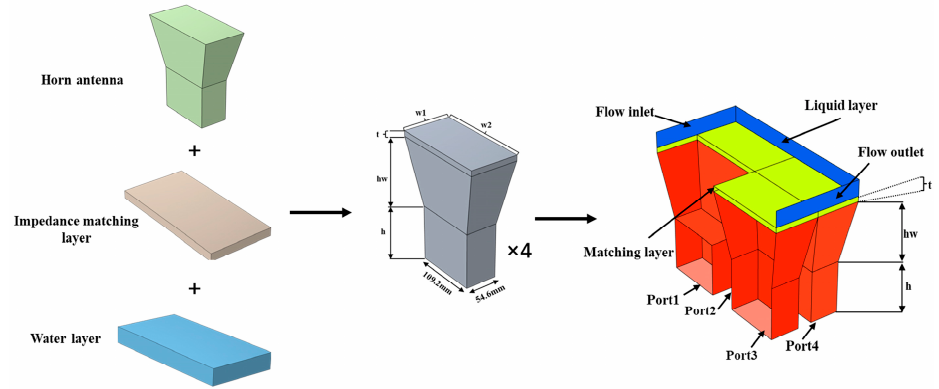
Figure 1. Integral geometry model.